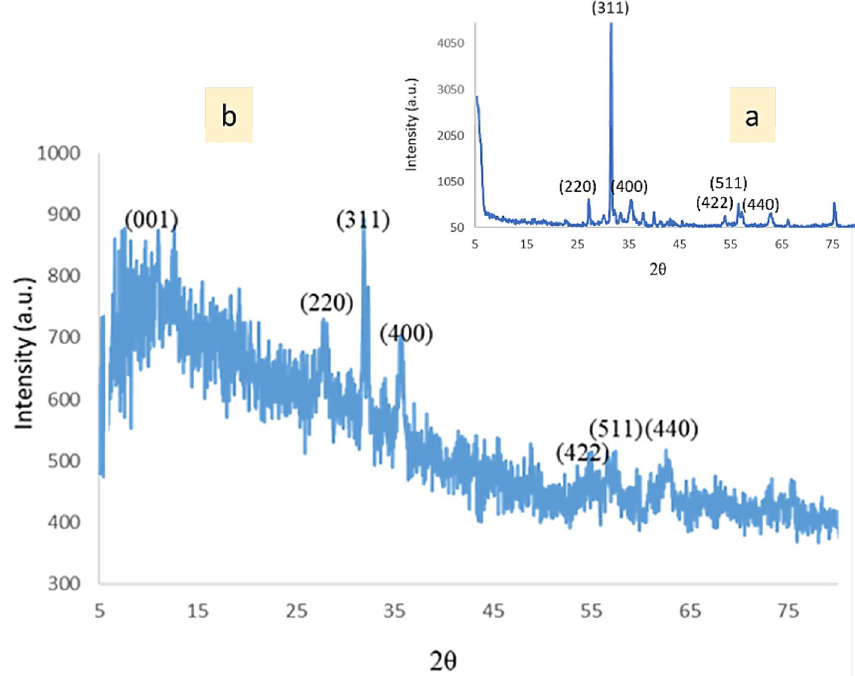
Figure 9. XRD patterns of the CuFe 2 O 4 ( a ) and SSE@GO-CuFe 2 O 4 ( b )